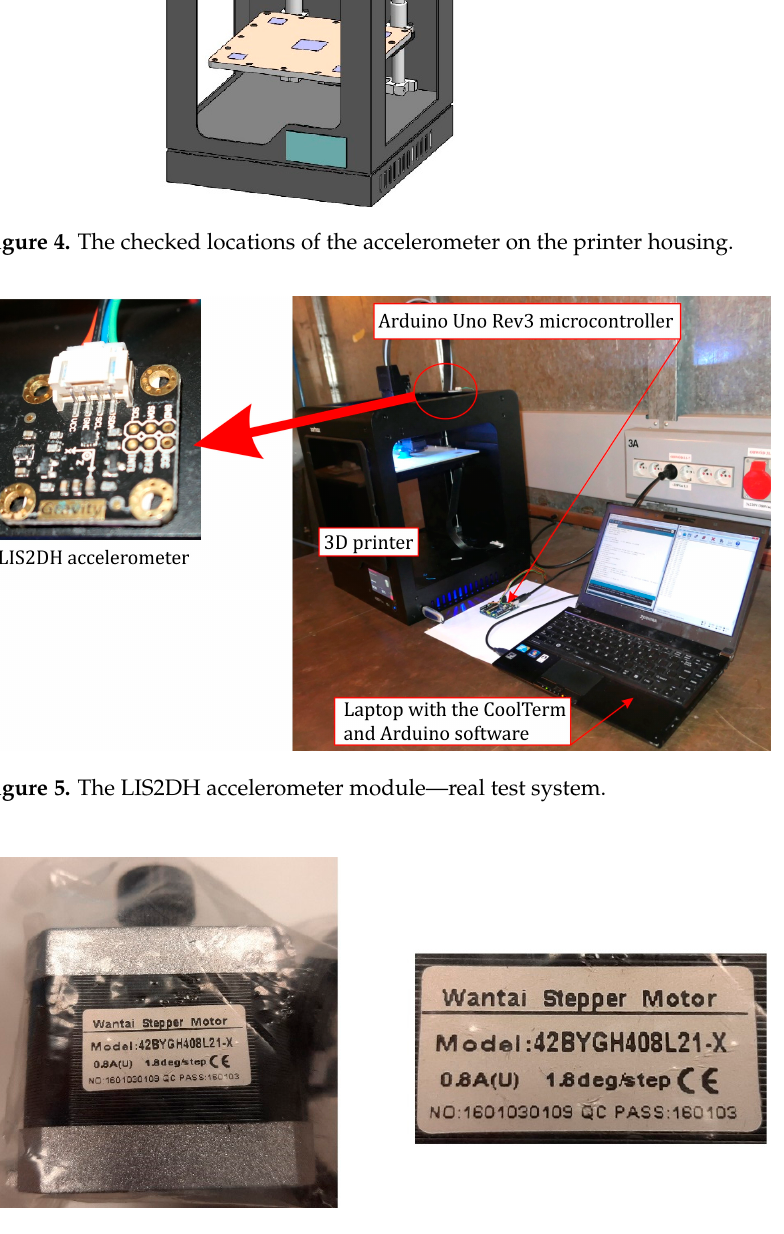
Figure 6. Stepper motor used in the tested 3D printer (axes X and Y,